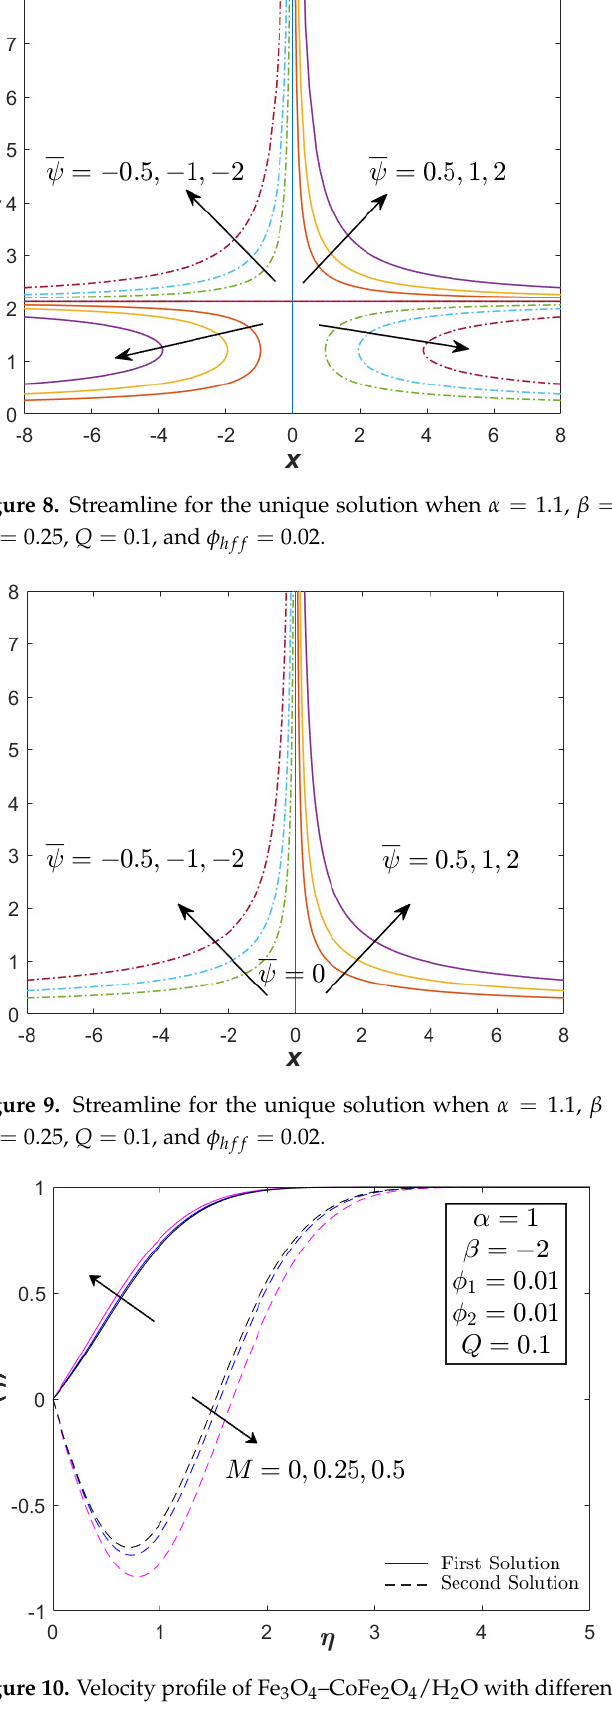
Figure 11. Temperature profile of Fe 3 O 4 –CoFe 2 O 4 /H 2 O with different M .